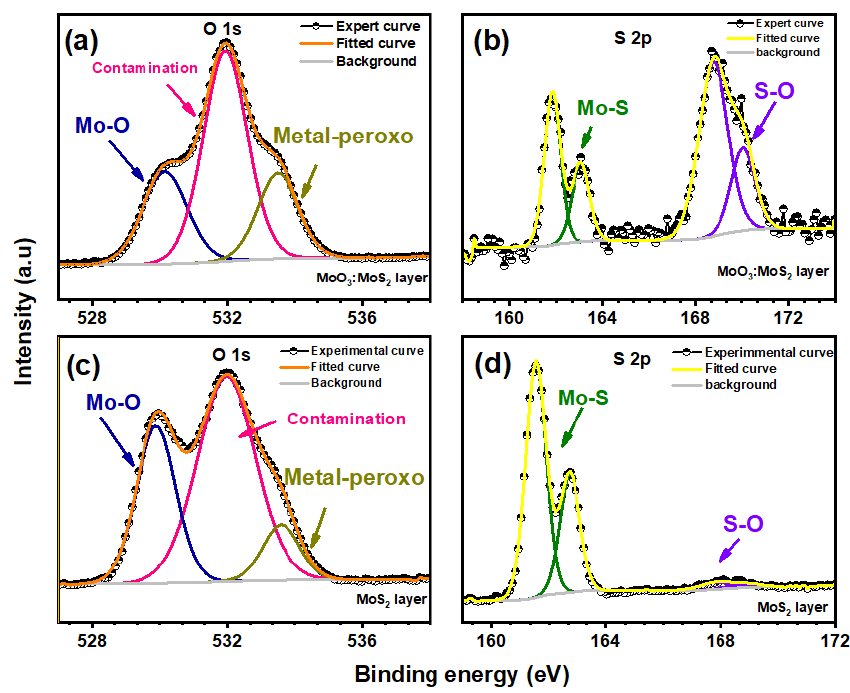
Figure 7. S2p and O 1s zone spectra of MoS 2 after reaction duration of 10 min ( a,b ) and MoS 2 before reaction ( c,d ) . reaction ( c , d